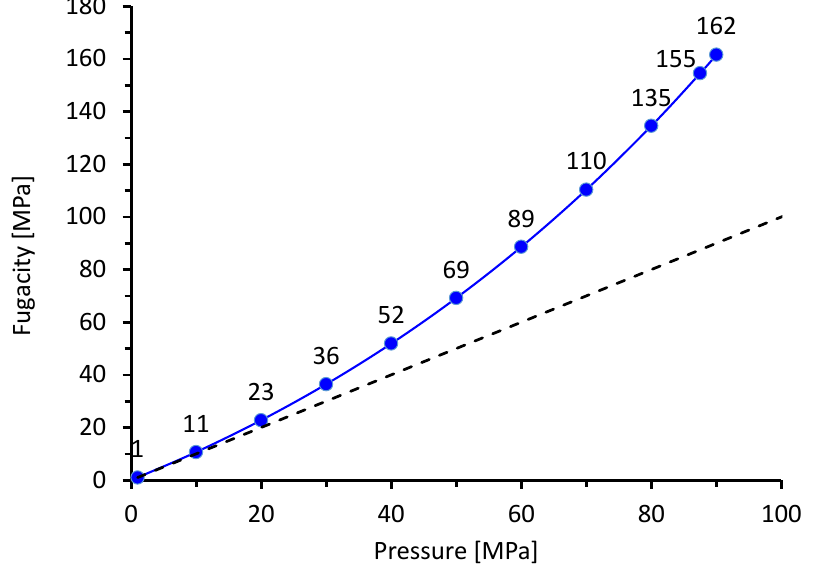
Figure 1. Correlation between pressure and fugacity at room temperature calculated by Equation (1). In the following, the data were analyzed in terms of fugacity instead of pressure. Based on this analysis, the experimental data were fitted using the following